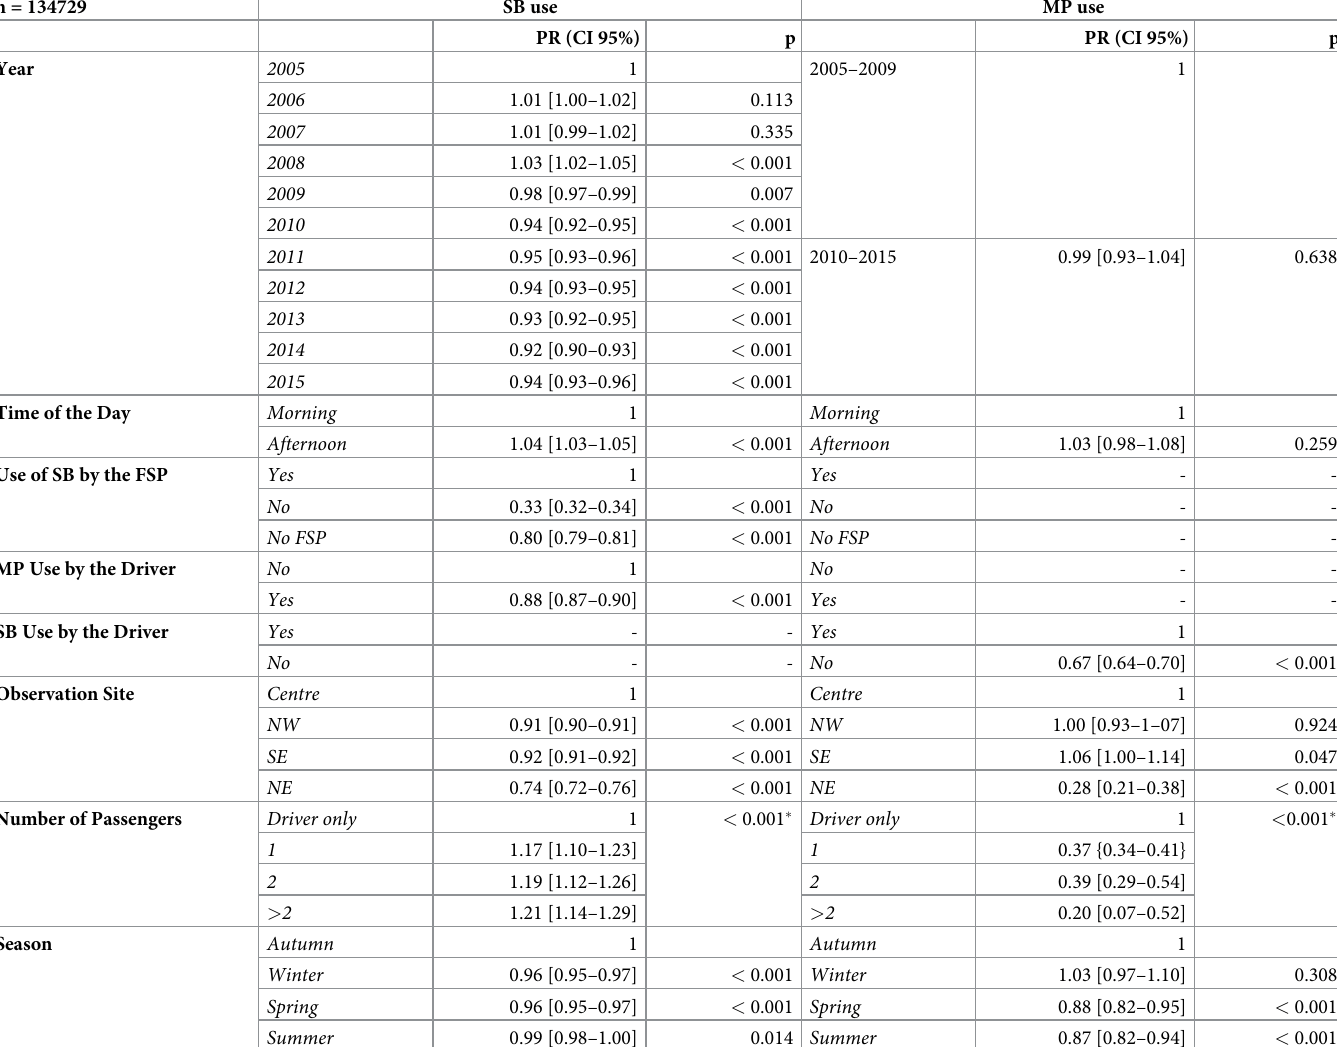
Table 3. On the left side, multivariate association between covariates and SB use while driving, 2005–2015. On the right side, multivariate association between covariates and MP use while driving, 2005–2015 (Poisson regression with robust variance). n = 134729